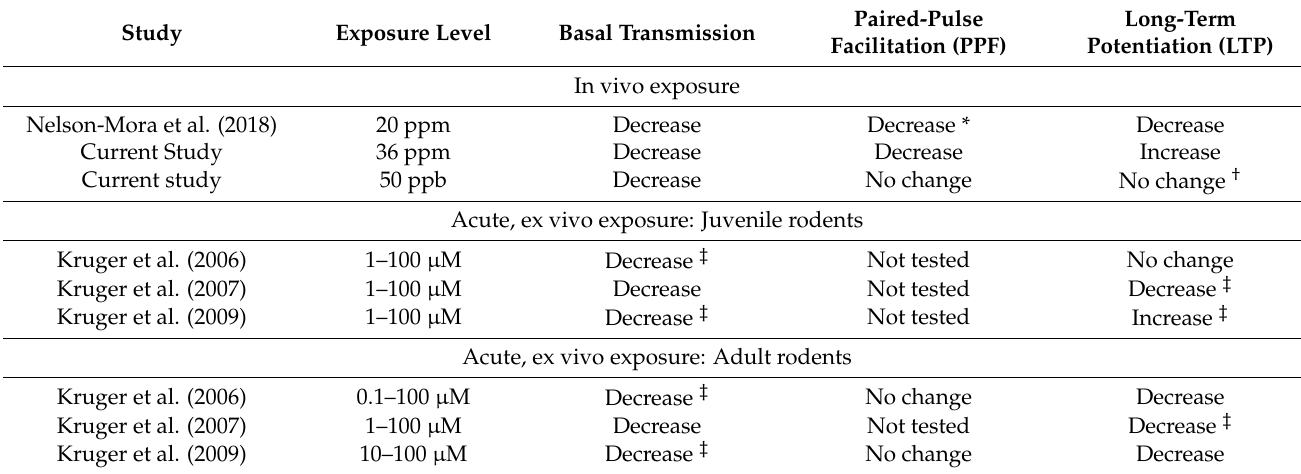
Table 2. Effect of arsenic exposure on synaptic function varies by exposure